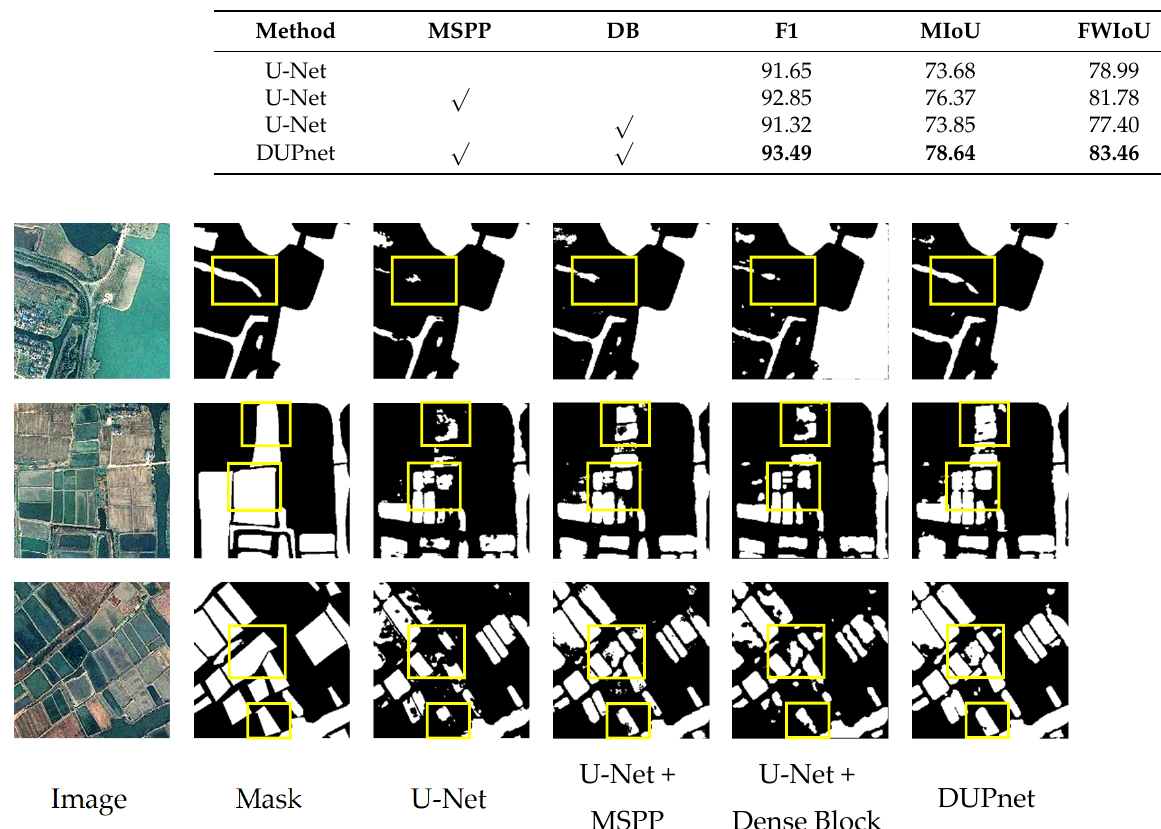
Figure 7. Visualization of extraction results of water bodies for ablation studies on the 2020 Gaofen challenge water body segmentation dataset.